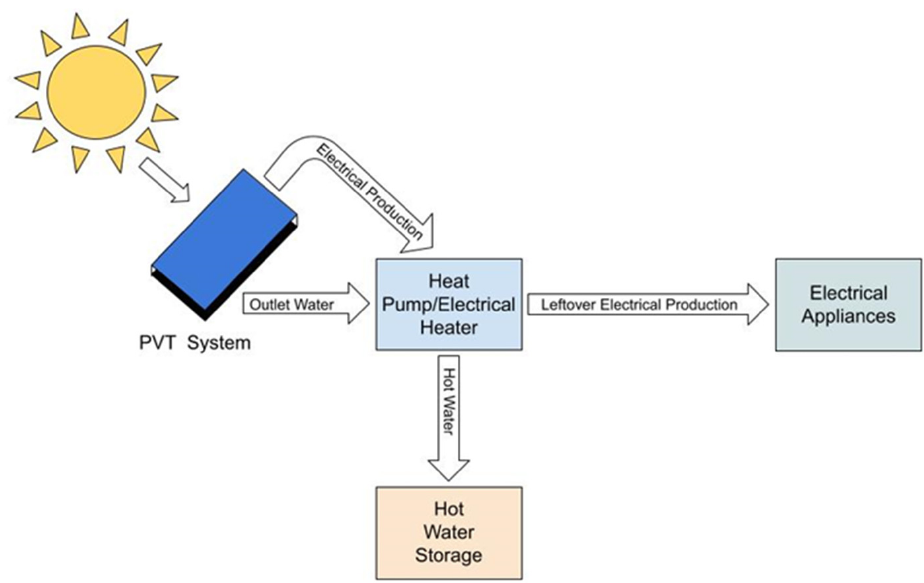
Figure 2. Domestic hot water supply with PVT system equipped with an electrical backup.